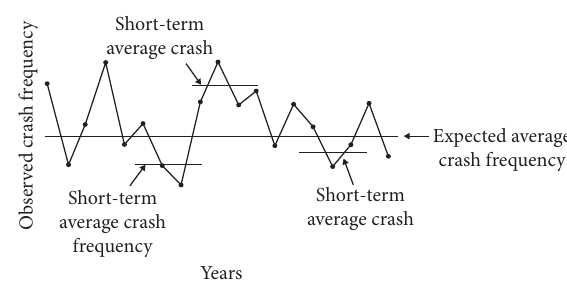
Figure 4: Rtm effect on crash rate prediction [29].